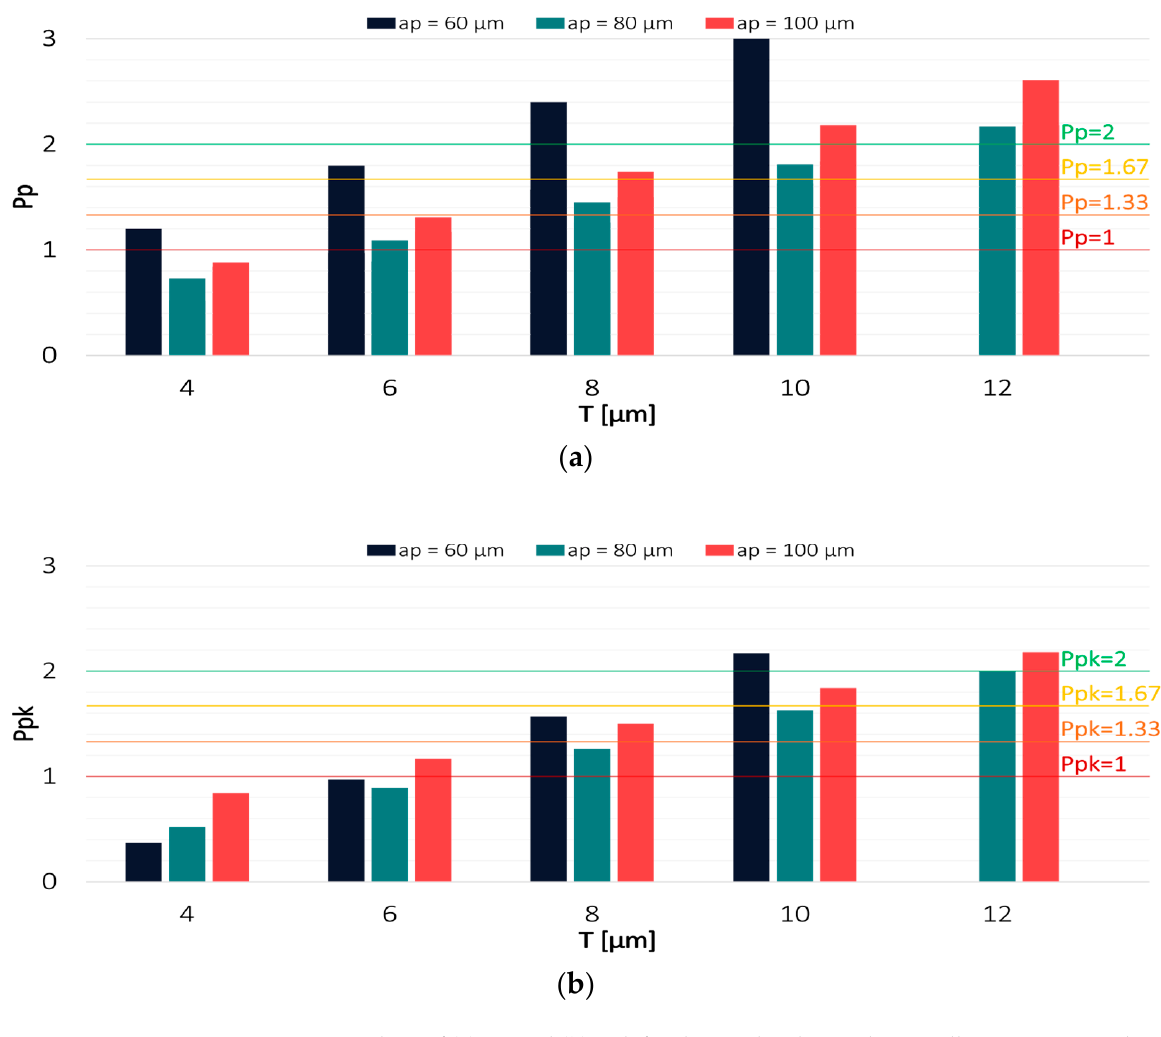
Figure 9. Values of ( a ) Pp and ( b ) Ppk for the results obtained in a milling process conducted with variable axial depth of cut and TiB 2 -coated tool.